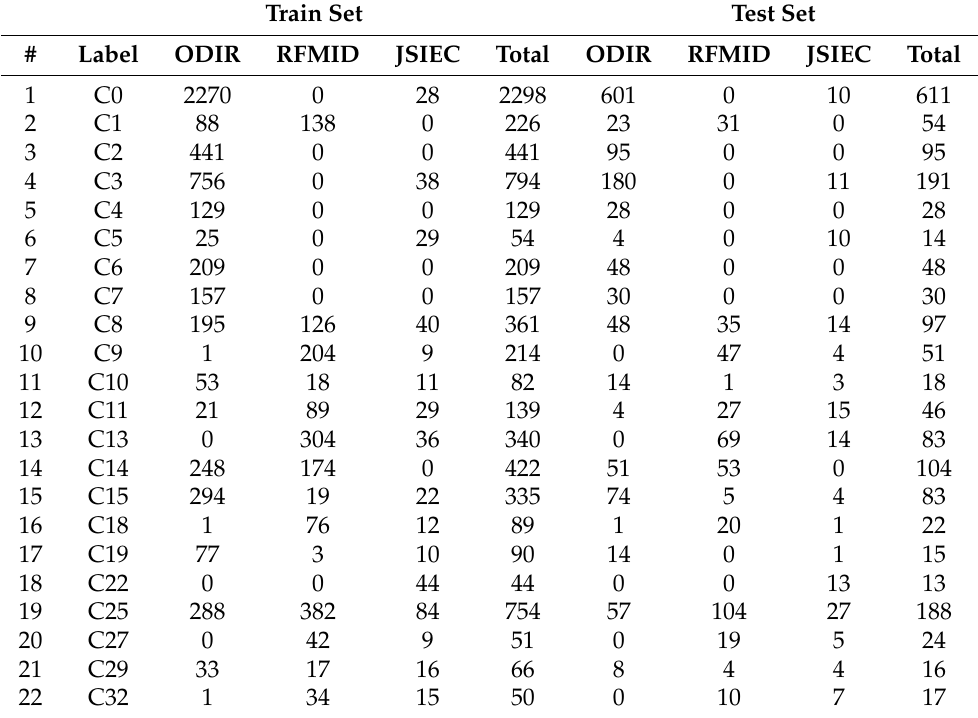
Table 3. Resident dataset: Numerical description of the train and test